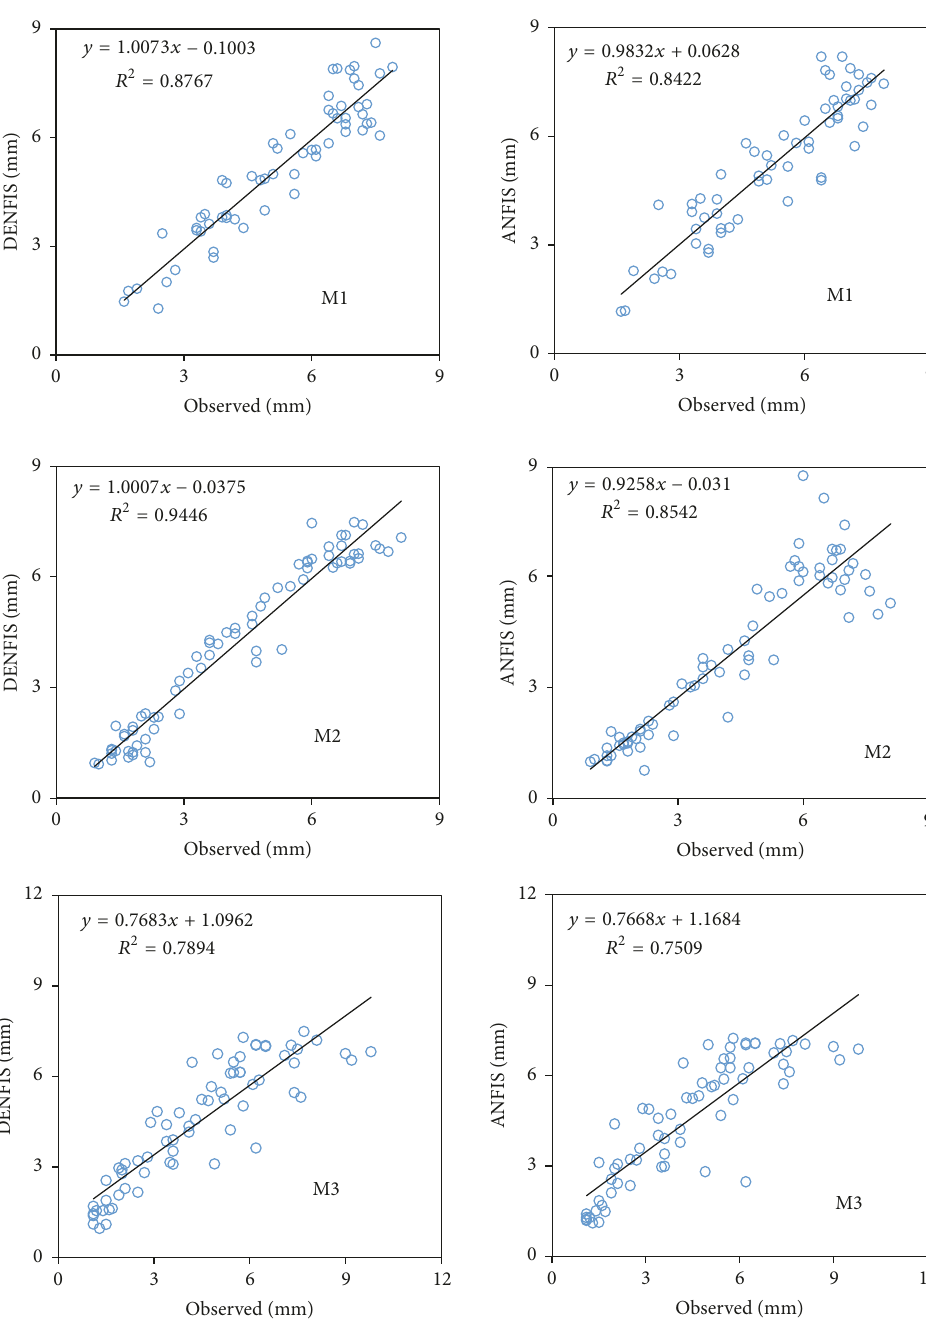
for MARE, and 8.29% for NS. ANOVA test results indicated the superior accuracy of the DENFIS to the ANFIS